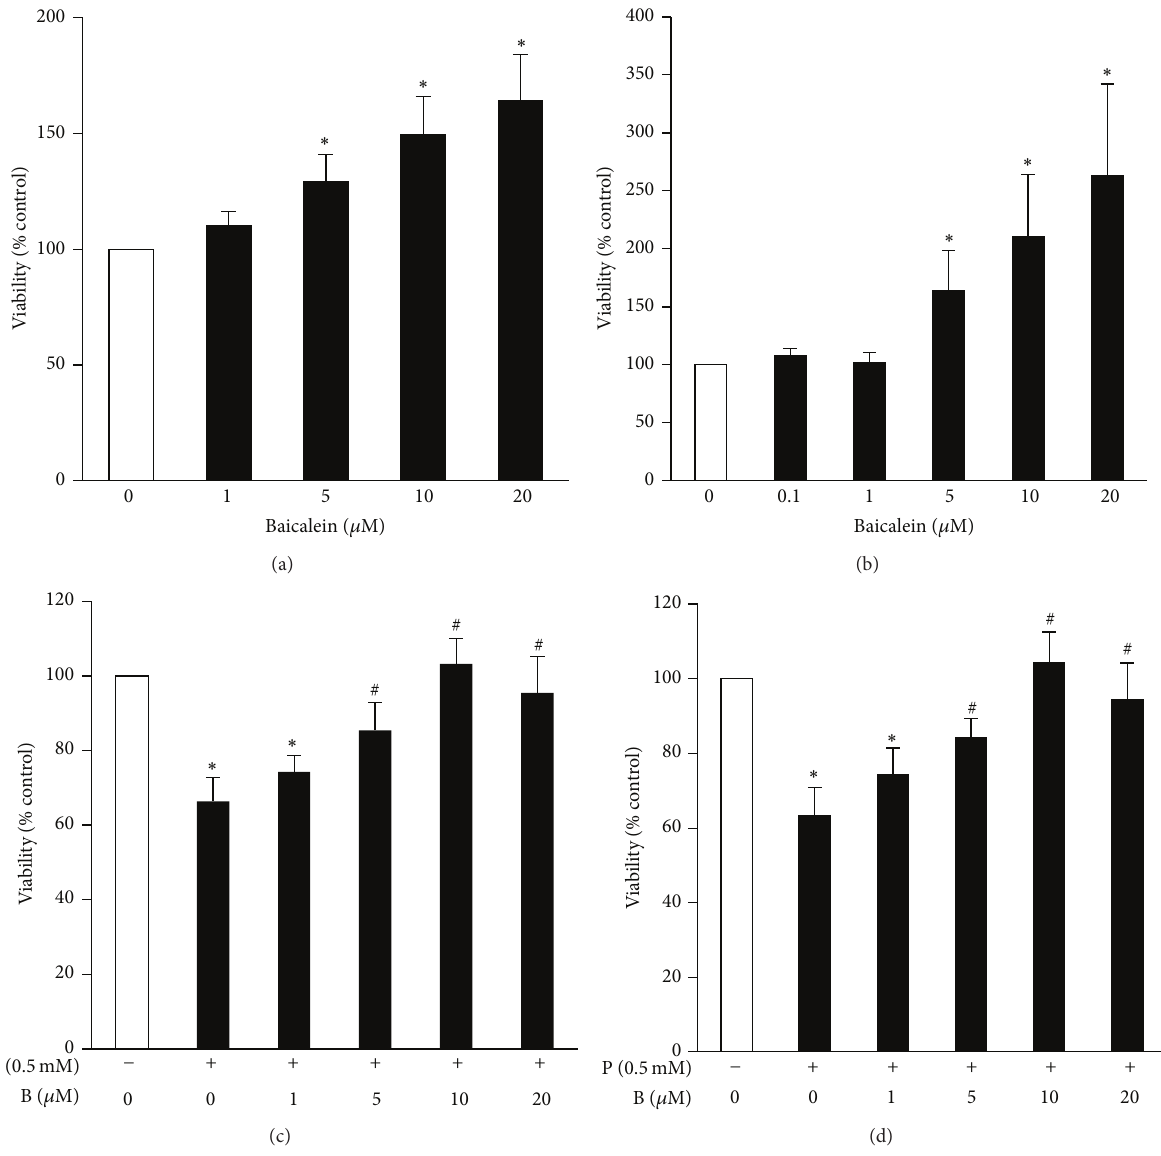
Figure 6: Baicalein promoted viability of 𝛽 -cells and human islets. INS382/13 cells (a) or human islets (100 islets/well) (b) were cultured in RPMI medium containing 5.5 mM glucose and 2% FBS in the presence or absence of various concentrations of baicalein for 24h. Cell viability was measured using a Cell Titer-Blue Cell viability assay kit. INS382/13 cells (c) or human islets (150 islets/well) (d) were cultured in RPMI medium containing 0.5 mM palmitate (P) or vehicle with or without various concentrations of baicalein (B) for 3d. Cell viability was assessed as above. Data are expressed as mean ± SE from 3-4 independent experiments with quadruplicate determinations each. ∗ 𝑃 < 0.05 versus control, # 𝑃 < 0.05 versus palmitate-alone treated cells or